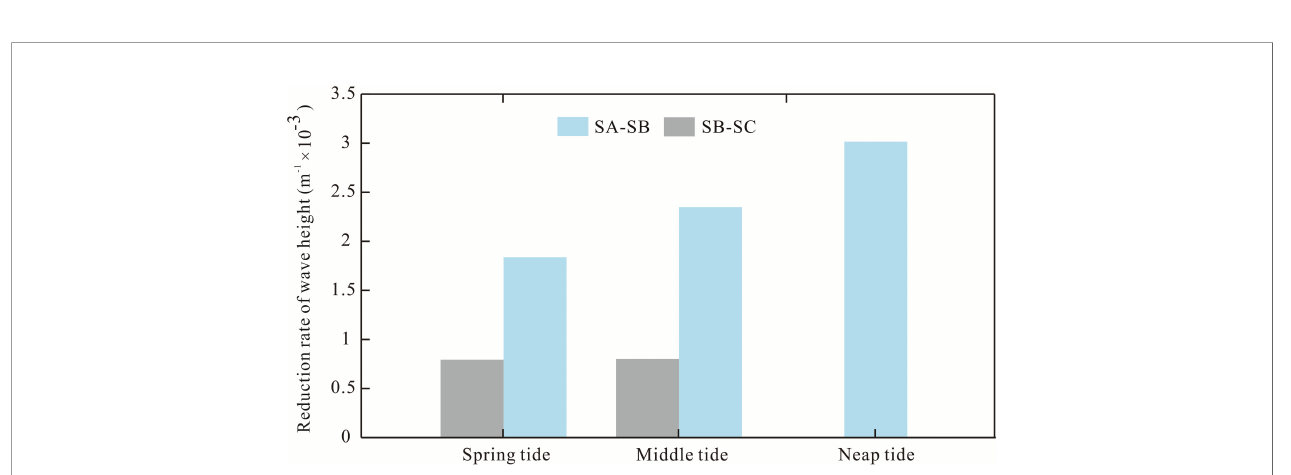
FIGURE 7 | Wave height reduction rate from spring to the neap tide. Blue bars are the rate along the transect from tripod SA to SB, and gray bars are the rate along the transect from tripod SB to